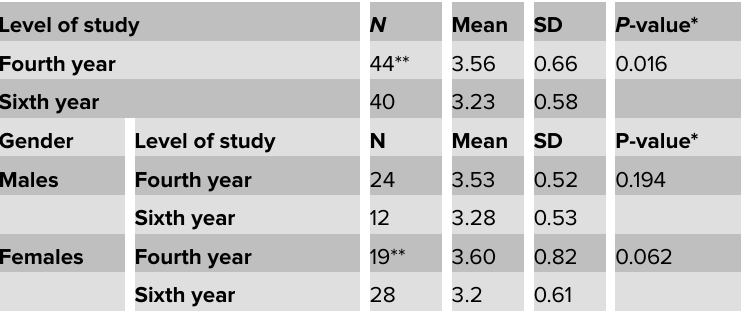
TABLE 5: Comparison between the overall response of the students to the Likert-type questions according to their level of study and gender ( N = 89).